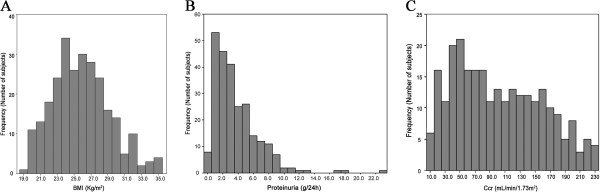
Histogram of weight mass index (A), proteinuria (B) and creatinine clearance rate (C) distribution among study subjects with diabetic nephropathy.